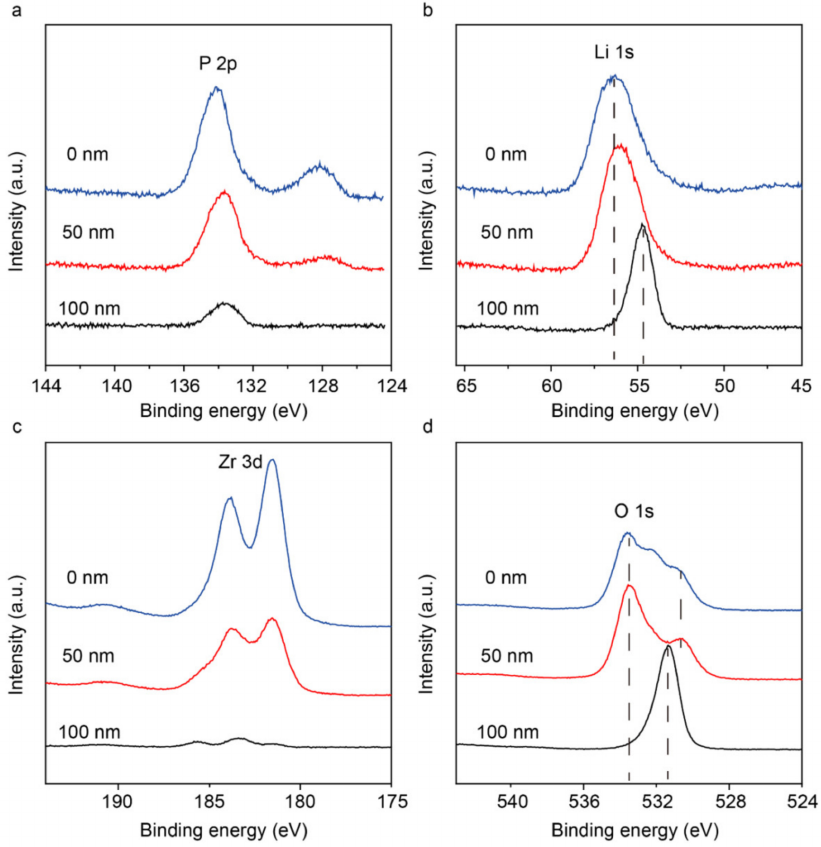
Figure 5. The XPS spectra of LY0.1ZP cycled in a Li / Li cell. The evolution profiles of relative ( a ) P, ( b ) Li, ( c ) Zr, ( d ) O elemental intensities along the depth direction. The separation distance was 50 nm, calculated from the Ar